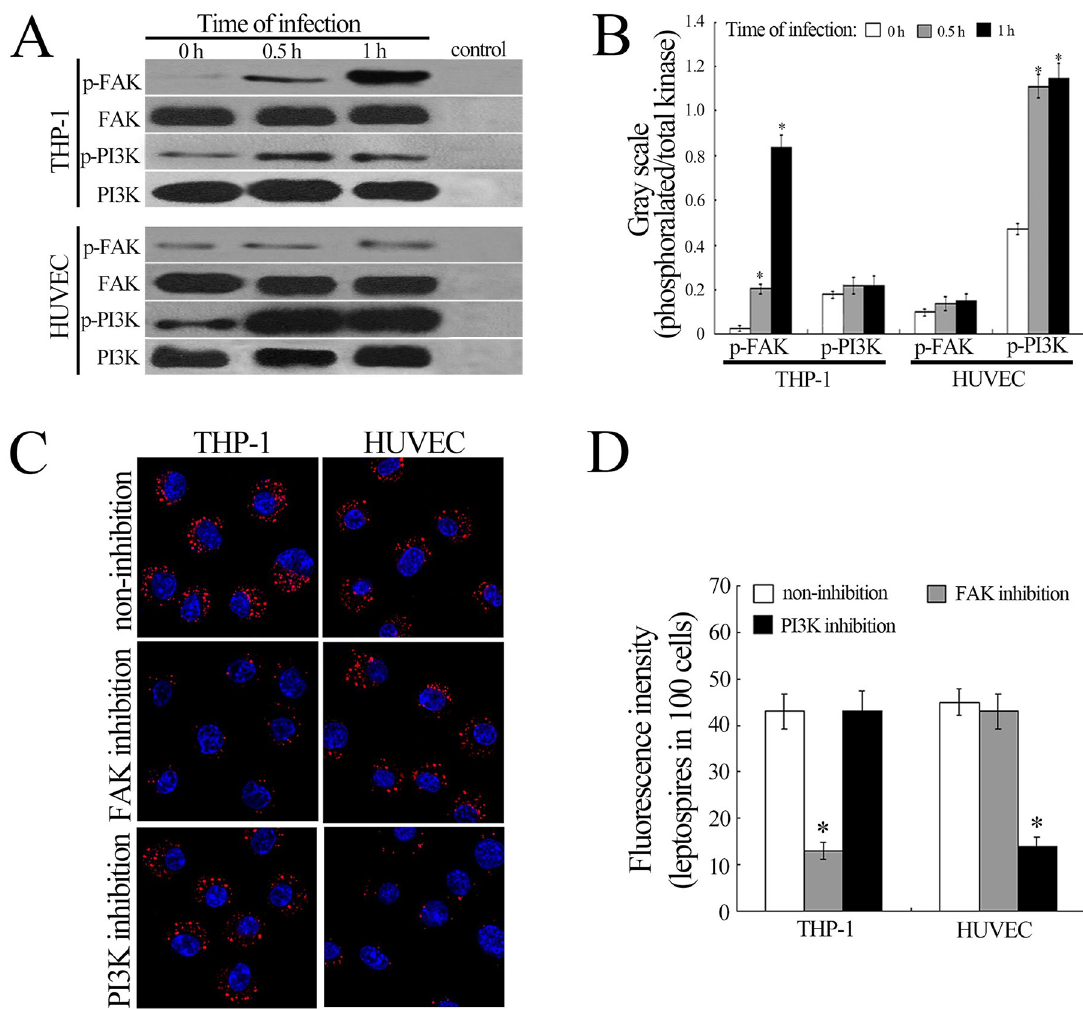
Fig 4. Phosphorylation of FAK and PI3K and cytoskeletal rearrangement in leptospire-infected cells. A: Phosphorylation of FAK in THP-1 and PI3K in HUVEC during infection with L . interrogans strain Lai for the indicated times; B: Quantification of immunoblotting bands reflecting FAK and PI3K phosphorylation in leptospire-infected THP-1 cells or HUVEC for the indicated times. Statistical data from experiments such as shown in A. Bars show the means ± SD of three independent experiments. � : p < 0.05 vs the phosphorylation level (gray scale) of FAK or PI3K in the cells before infection; C: Leptospires in FAK- or PI3K-inhibited THP-1 and HUVEC after infection with L . interrogans strain Lai for 1 h. The blue plaques in the middle of cells indicate the nuclus. The red spots around the nuclus indicate the intracellular leptospires; D: Statistical summary of red fluorescence intensity reflecting the leptospires in FAK or PI3K-inhibited leptospire-infected cells. Statistical data from experiments such as shown in C. Bars show the means ± SD of three independent experiments. One hundred cells were analyzed for each of the specimens. � : p < 0.05 vs the red fluorescence intensity reflecting the leptospires in the FAK-uninhibited THP-1 or PI3K-uninhibited HUVEC before infection.